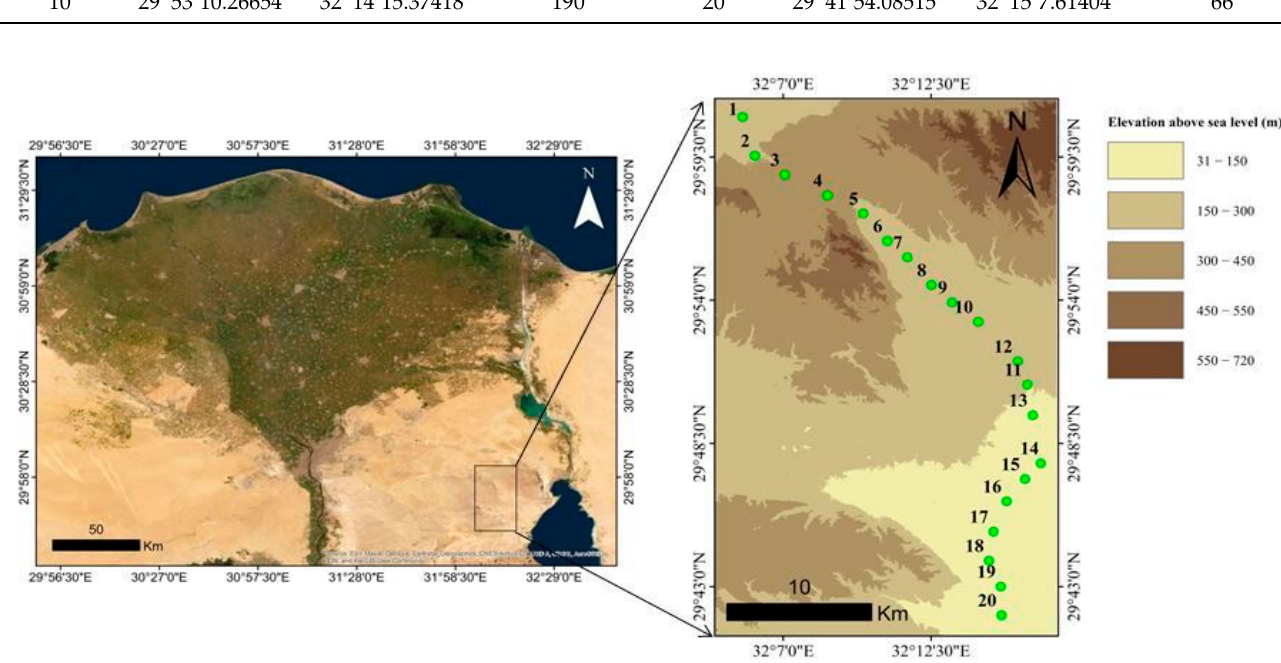
Figure 1. Location on the map showing the digital elevation model of Wadi Hagul.